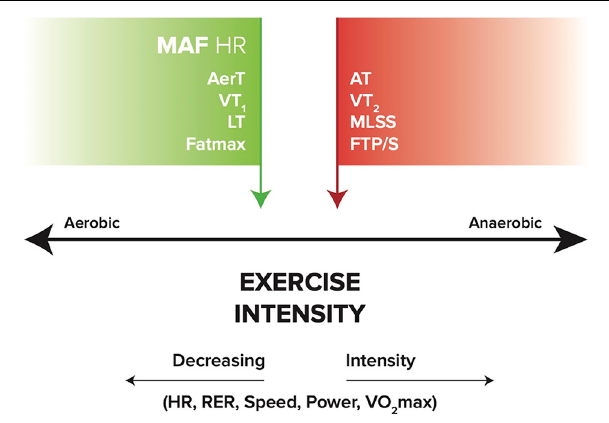
FIGURE 2 | General relationships between aerobic (MAF HR, AerT, VT 1 , LT, and Fatmax), anaerobic (MLSS, FTP/S, VT 2 , and AT), and exercise intensity (HR, RER, speed, power, and VO 2 max). Green arrow indicates MFO; red arrow indicates reduced fat oxidation. MAF HR, maximum aerobic function heart rate; AerT, aerobic threshold; VT 1 , first ventilatory threshold; LT, lactate threshold; MLSS, maximal lactate steady state; FTP/S, functional threshold power/speed; VT 2 , second ventilatory threshold; AT, anaerobic threshold; RER, respiratory exchange ratio; VO 2 max, maximal oxygen